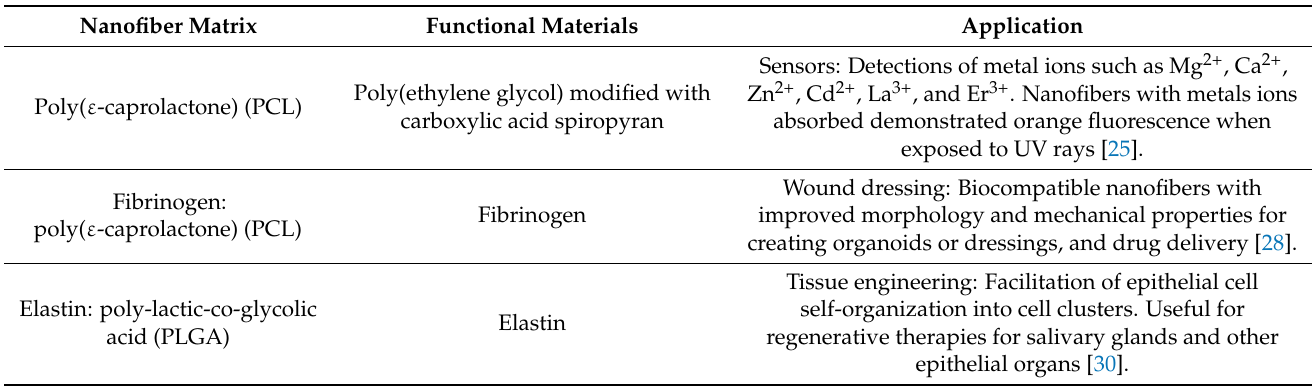
Table 1. Summarized nanofiber systems with remarkable characteristics and applications. Nanofiber Matrix Functional Materials Application Poly(ethylene glycol) modified